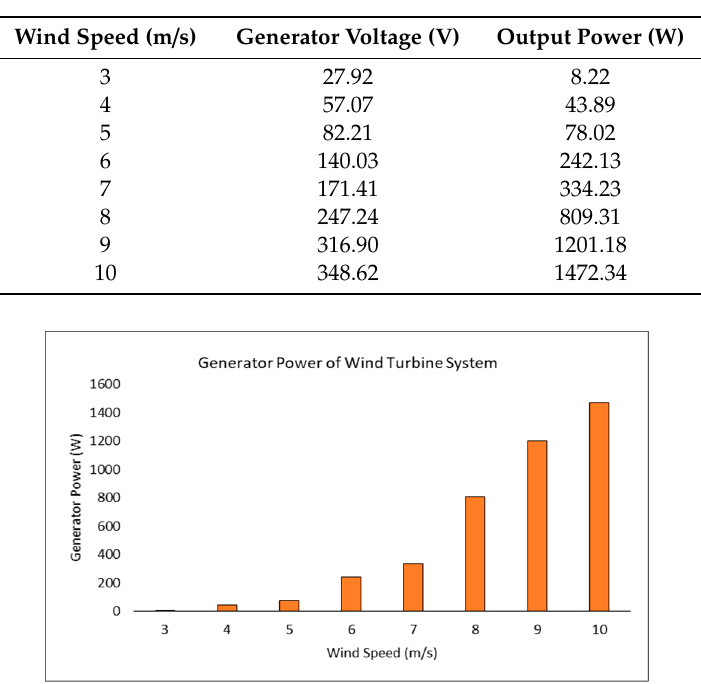
Table 7. Results of the PO algorithm sensitivity test.